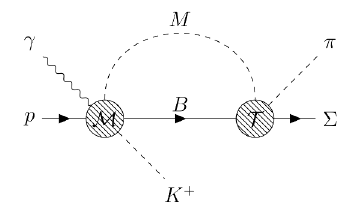
Figure 1. Illustration of the final-state interaction (FSI) of the meson-baryon pair. M represents the amplitude for the γ p → K + MB without FSI, and T is the meson-baryon scattering amplitude, which can be decomposed into partial waves f ℓ ±